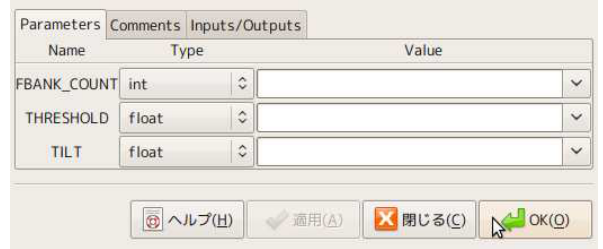
Figure 5. A parameter tab of a soft mask generation module.